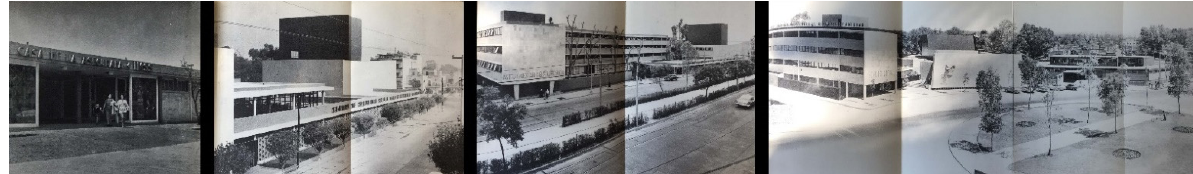
Figure 6. Pictures of newly built Casas de la Asegurada, in 1961. From left to right: unknown, CSSBF Xola, CSSBF Tepeyac, CSSBF Legaria. Source: left, López: [10]; rest, [15].